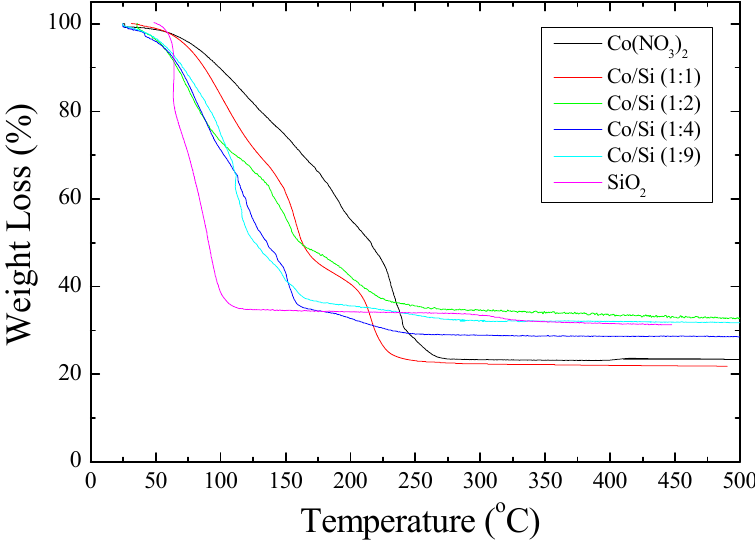
Figure 2. Thermogravimetric analysis of silica dispersion and 1 M cobalt nitrate solution with or without the catalyst precursor solution.